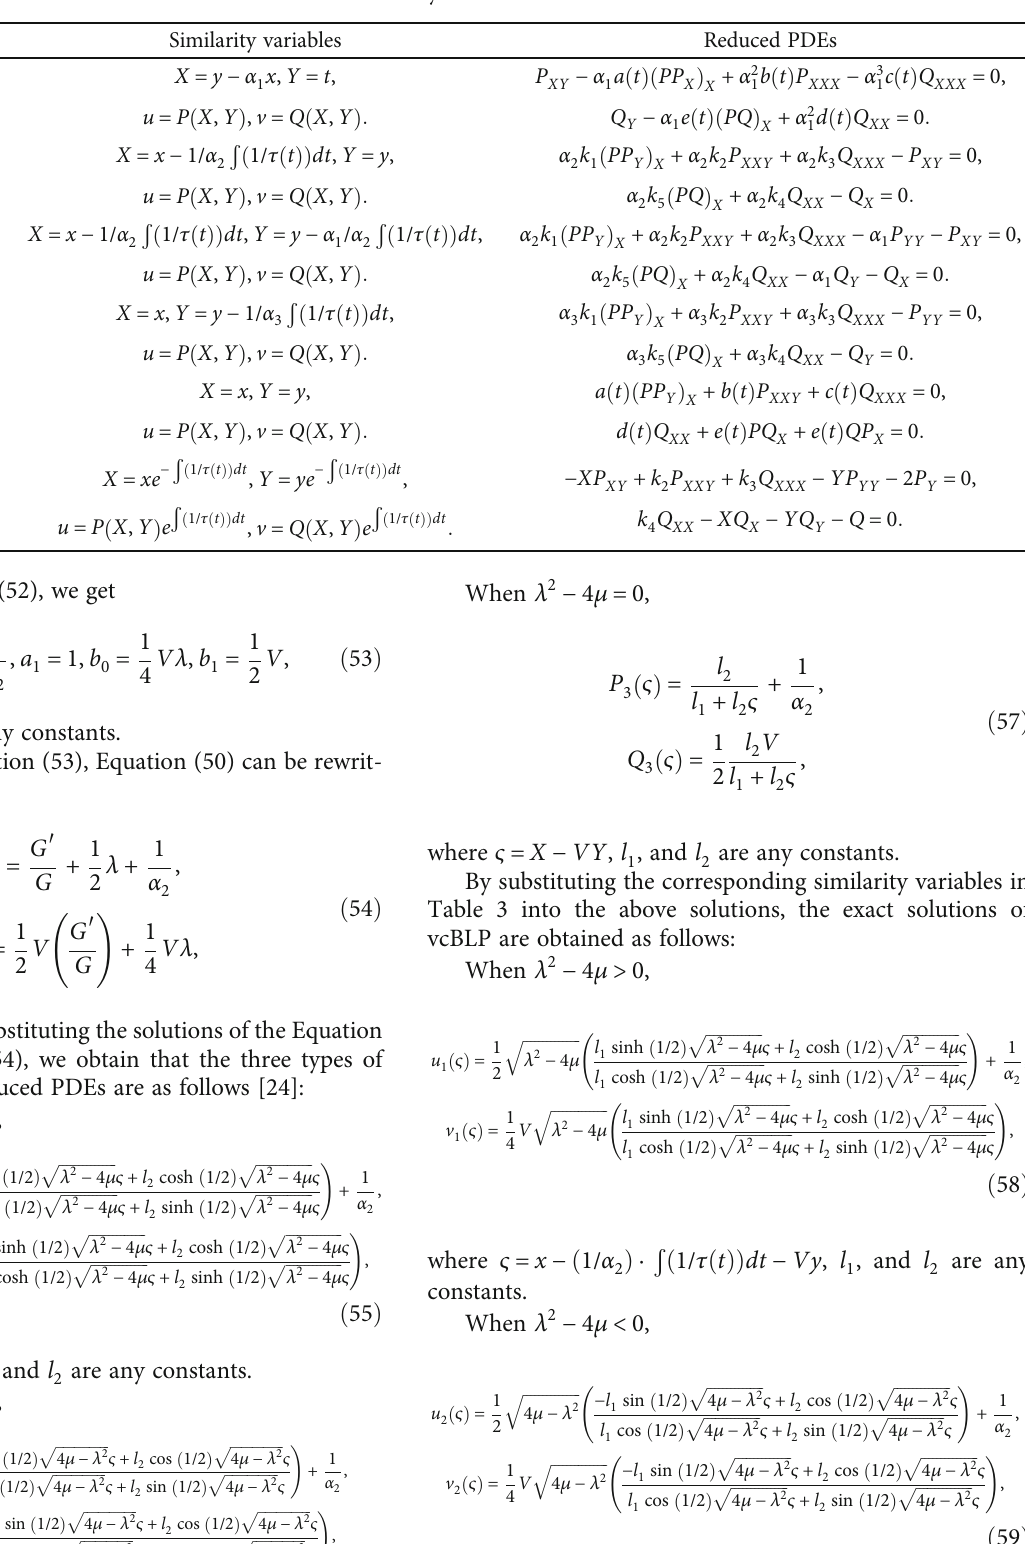
Table 3: Similarity